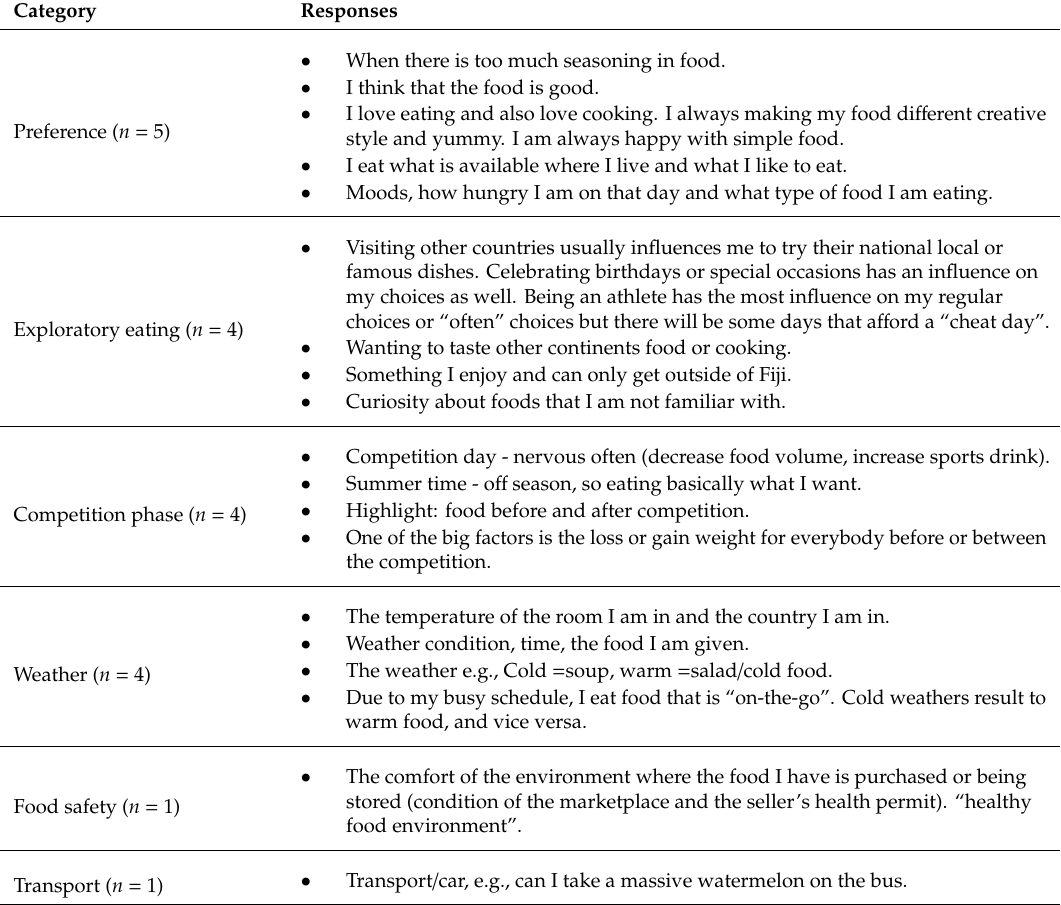
Table 3. Additional factors that athletes reported as influencing their food